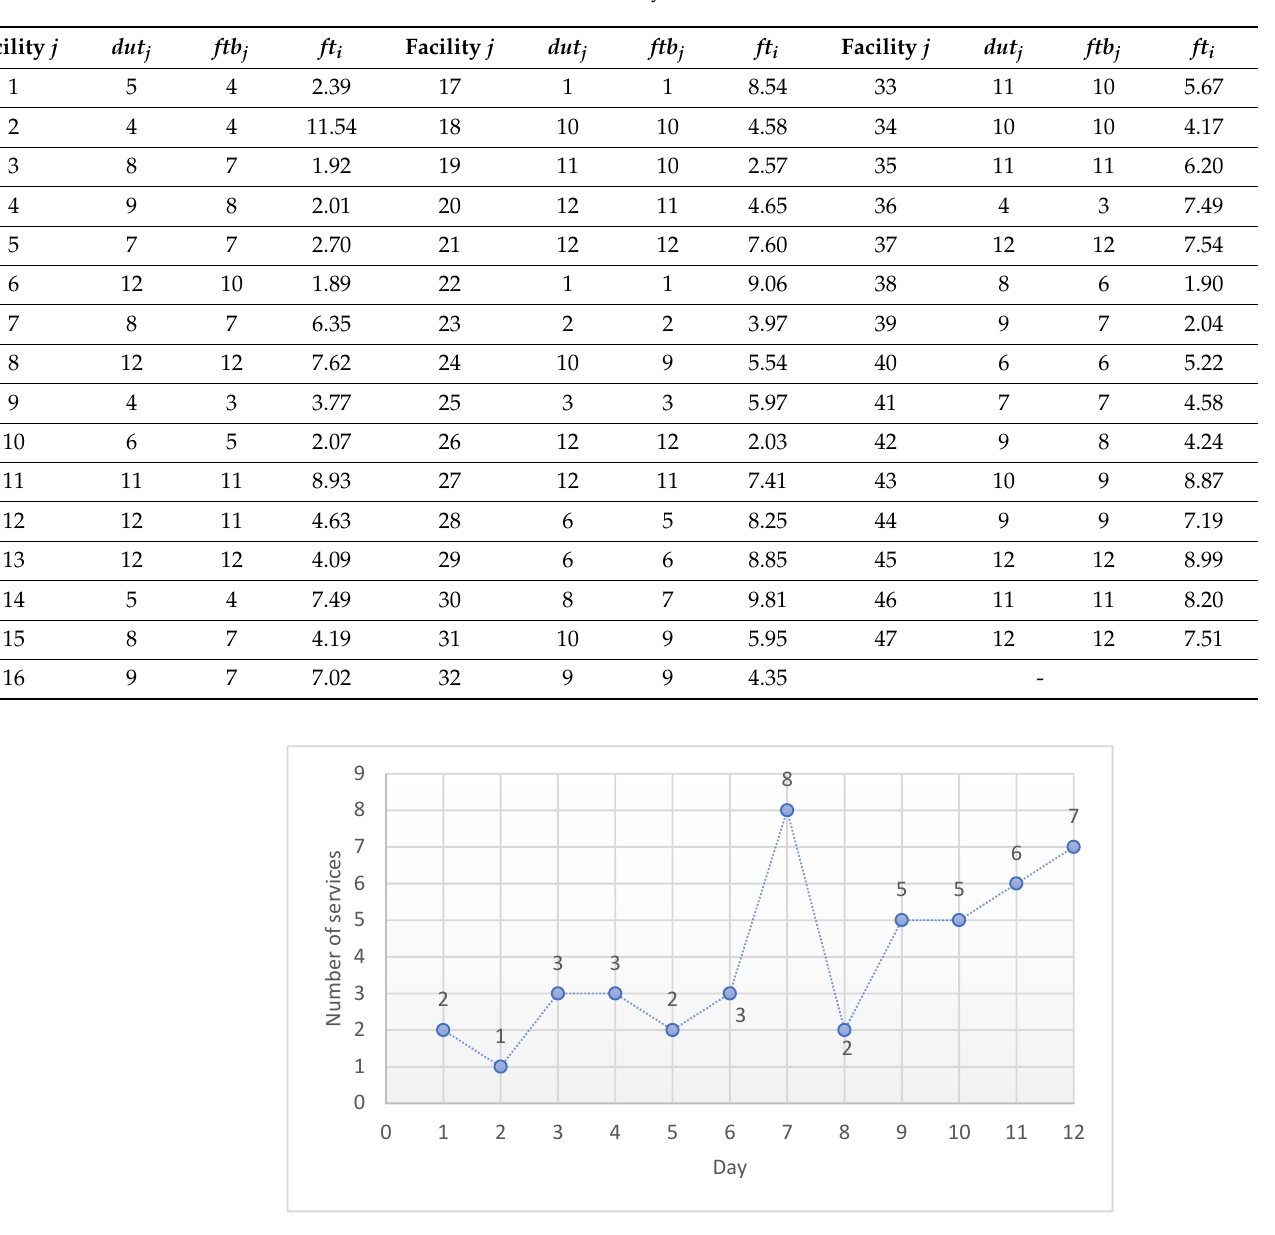
Figure 13. Number of finished service orders in each day.